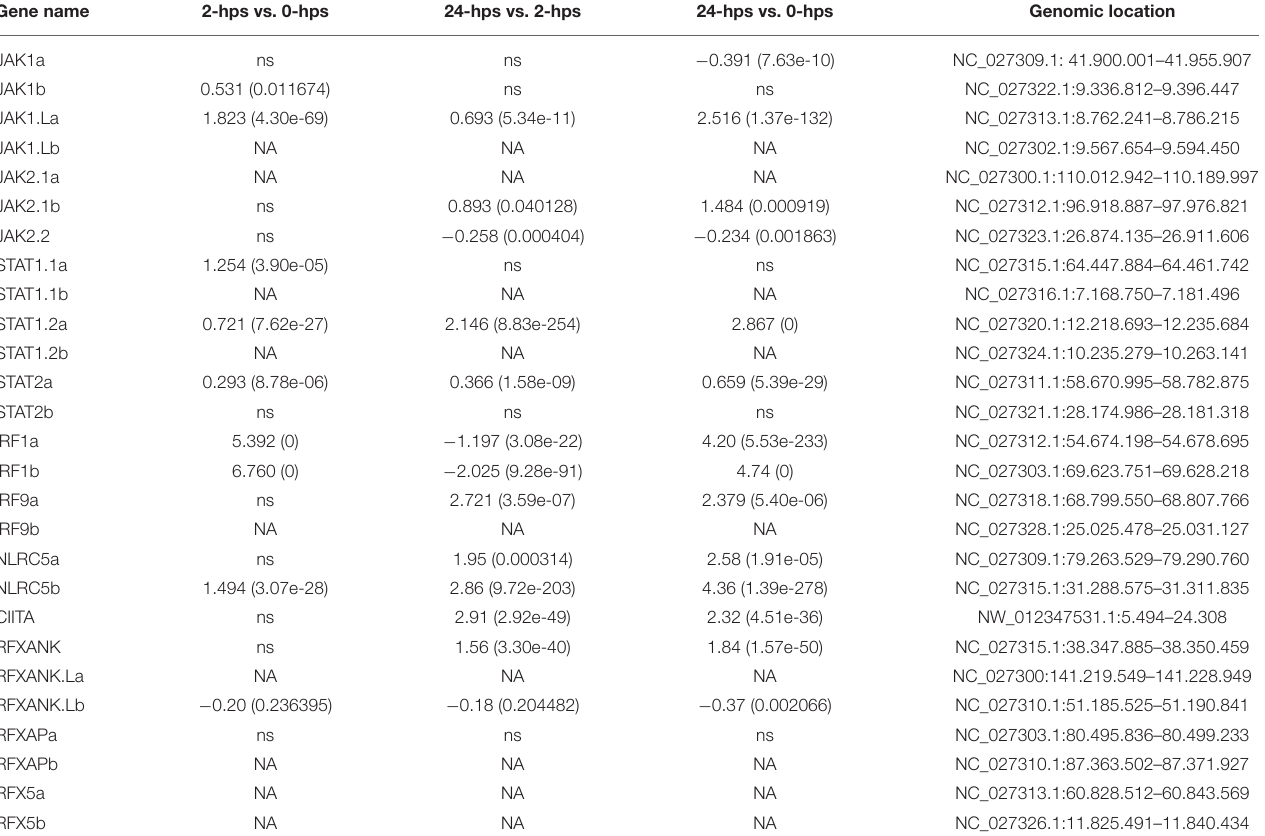
TABLE 1 | Log 2 fold change with adjusted P -values for selected transcription